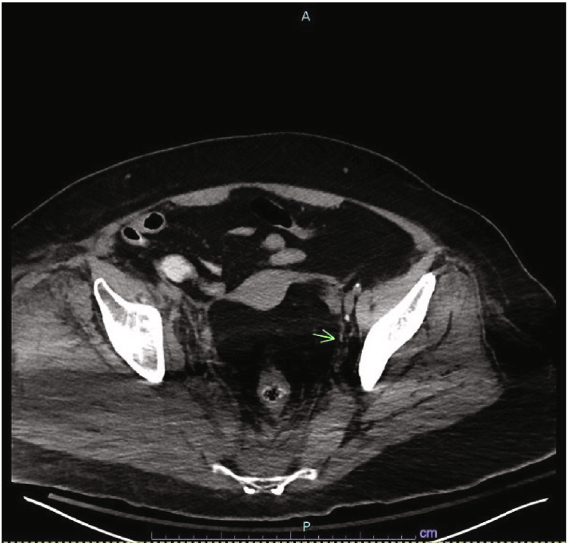
Figure 1: CT pelvis demonstrating asymmetrical swelling and stranding a ff ecting the right piriformis muscle with an arrow pointing to ureteral involvement in muscle